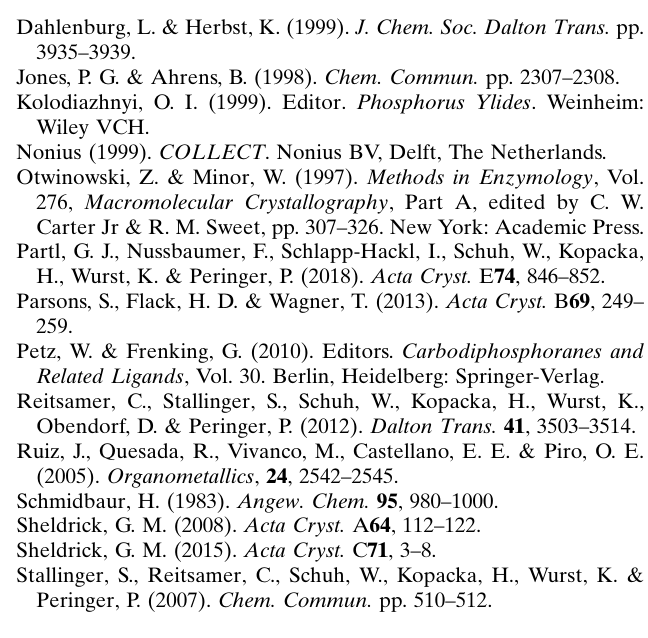
Crystal data Chemical